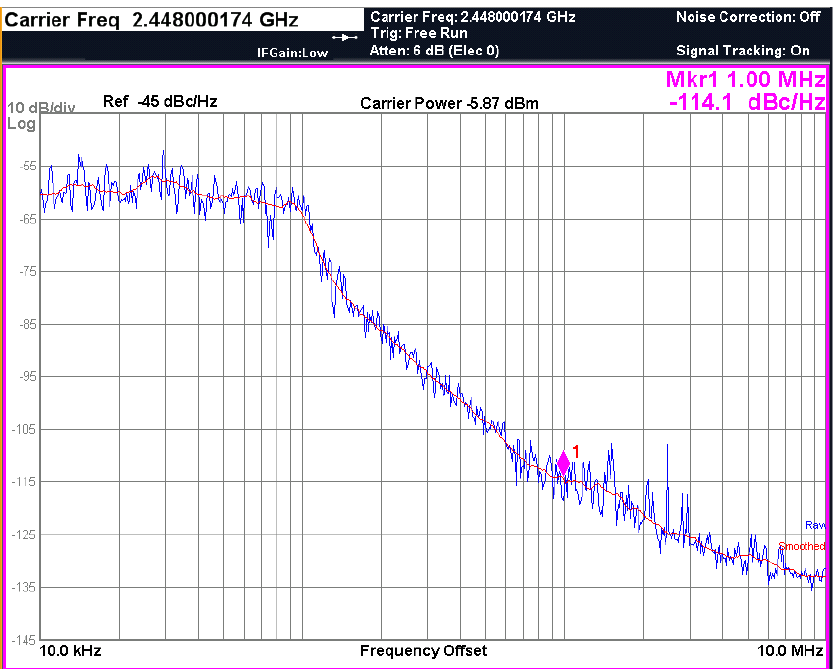
Figure 19. Measured phase noise performance of closed-loop ADPLL.